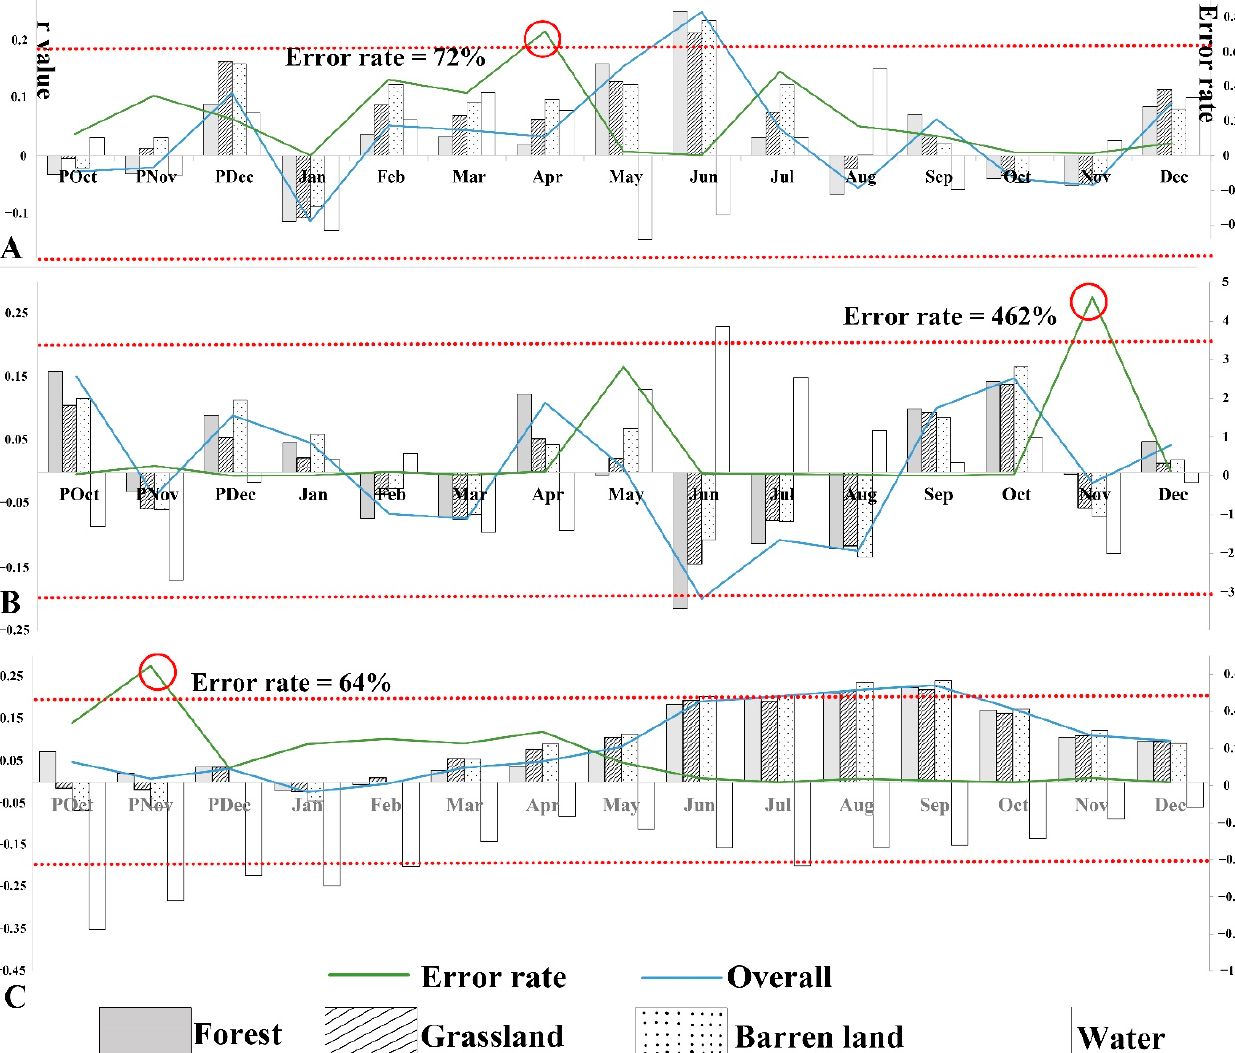
Figure 7. Correlations between chronology and climate factors. ( A ) Shows the correlations between monthly precipitation and NDVI values from 1906 to 2015. ( B ) Shows the correlations between monthly maximum temperature and NDVI values from 1906 to 2015. ( C ) Shows the correlations between monthly PDSI and NDVI values from 1906 to 2015. The red circle highlights the differences in the error rates between the overall and forest in some extreme cases. The dash lines are the 0.05 significant levels. PMonth indicates the specific month in the previous